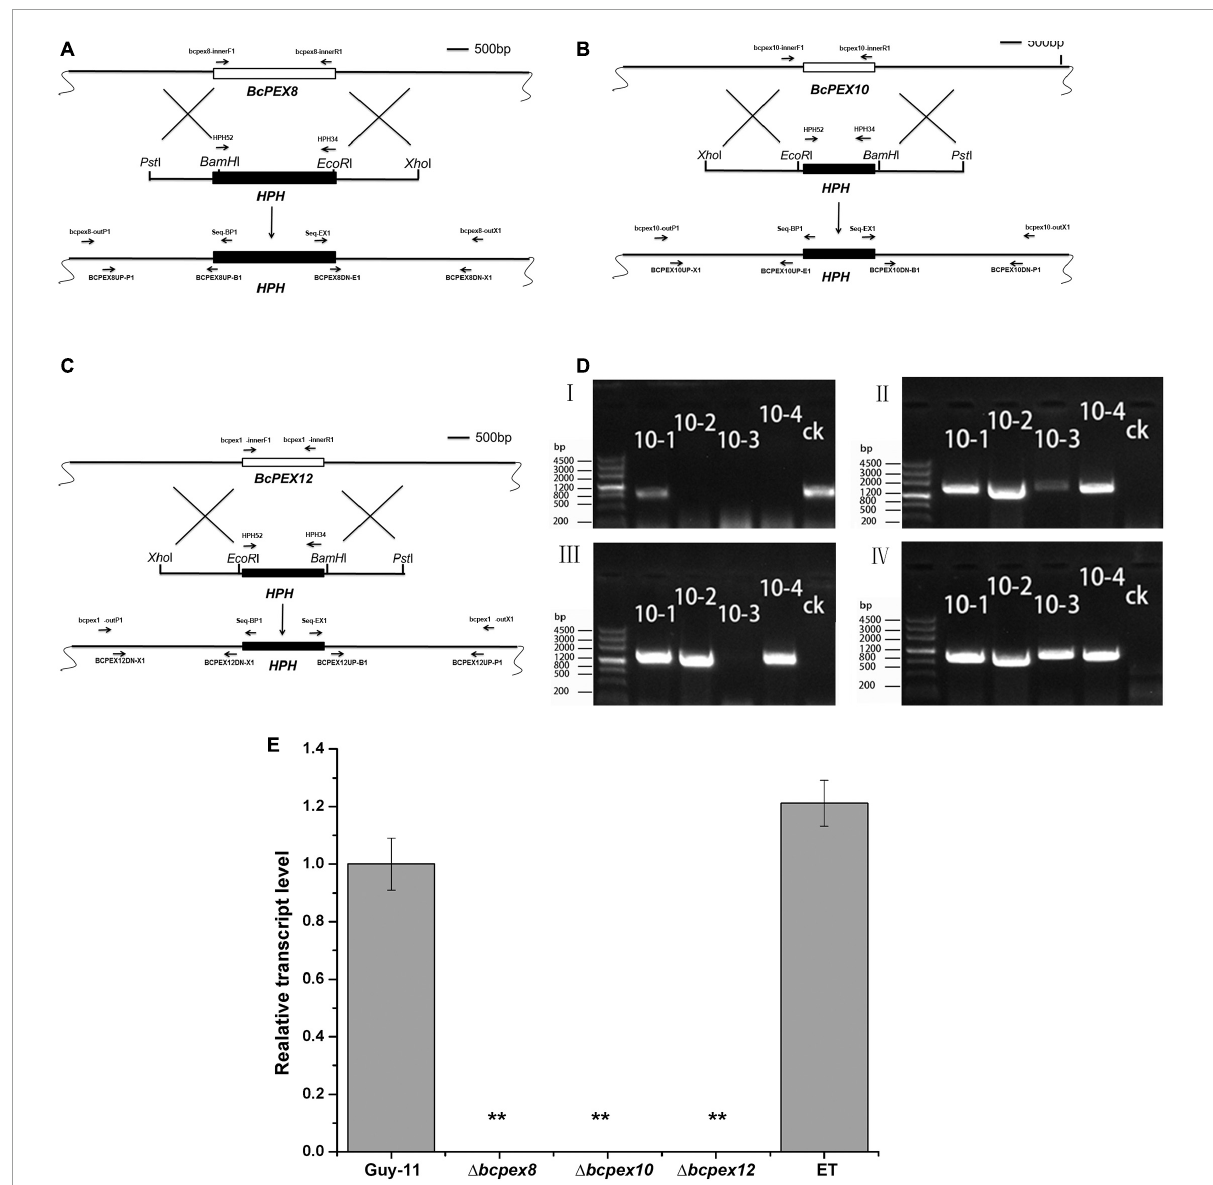
FIGURE2 BcPEX8 , BcPEX10, and BcPEX12 genes’ deletion. (A) Diagram showing that the 2.07-kb BcPEX8 coding region was replaced by the 1.36-kb HPH cassette. (B) Diagram showing that the 1.10-kb BcPEX10 coding region was replaced by the 1.36-kb HPH cassette. (C) Diagram showing that the 1.40-kb BcPEX12 coding region was replaced by the 1.36-kb HPH cassette. Scale bar, 500 bp. The locations of the primers are indicated with arrows, and primers in the same color were used as a pair. (D) Genomic polymerase chain reaction (PCR) was used to validate the deletion